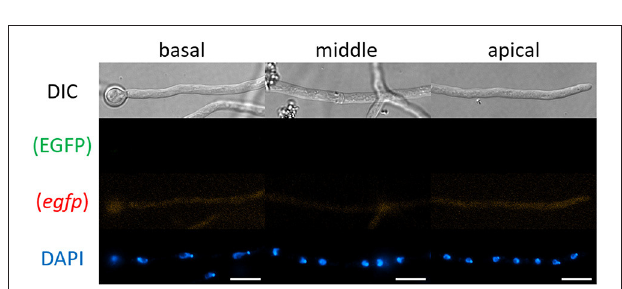
FIGURE 2 | smFISH using the egfp probe onto cells of A. oryzae RIB40 wild-type strain. No EGFP and red fluorescence appeared in any hyphal regions. Nuclei were stained with DAPI. Bars, 10 µ